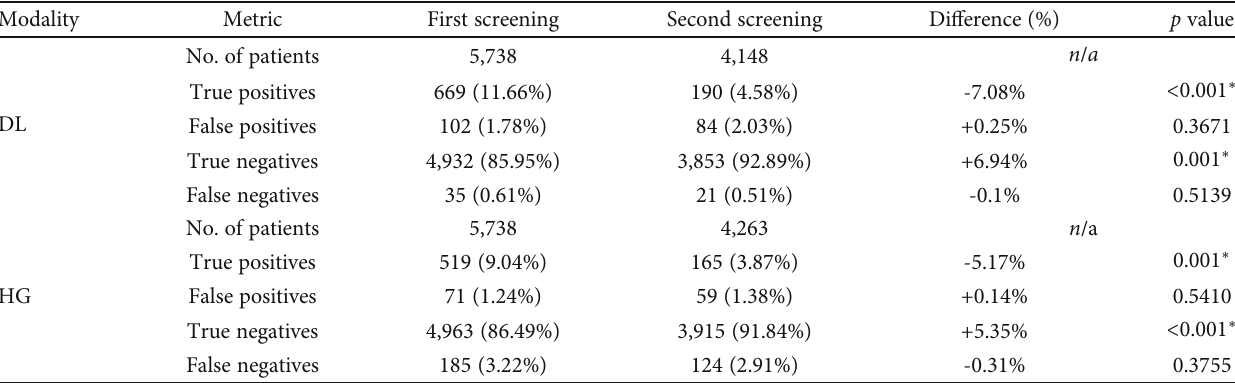
Table 3: The number of patients in the fi rst and second screening in each cell of the contingency table (true positive, false positive, true negative, and false negative) for detecting sight threatening diabetic retinopathy by each